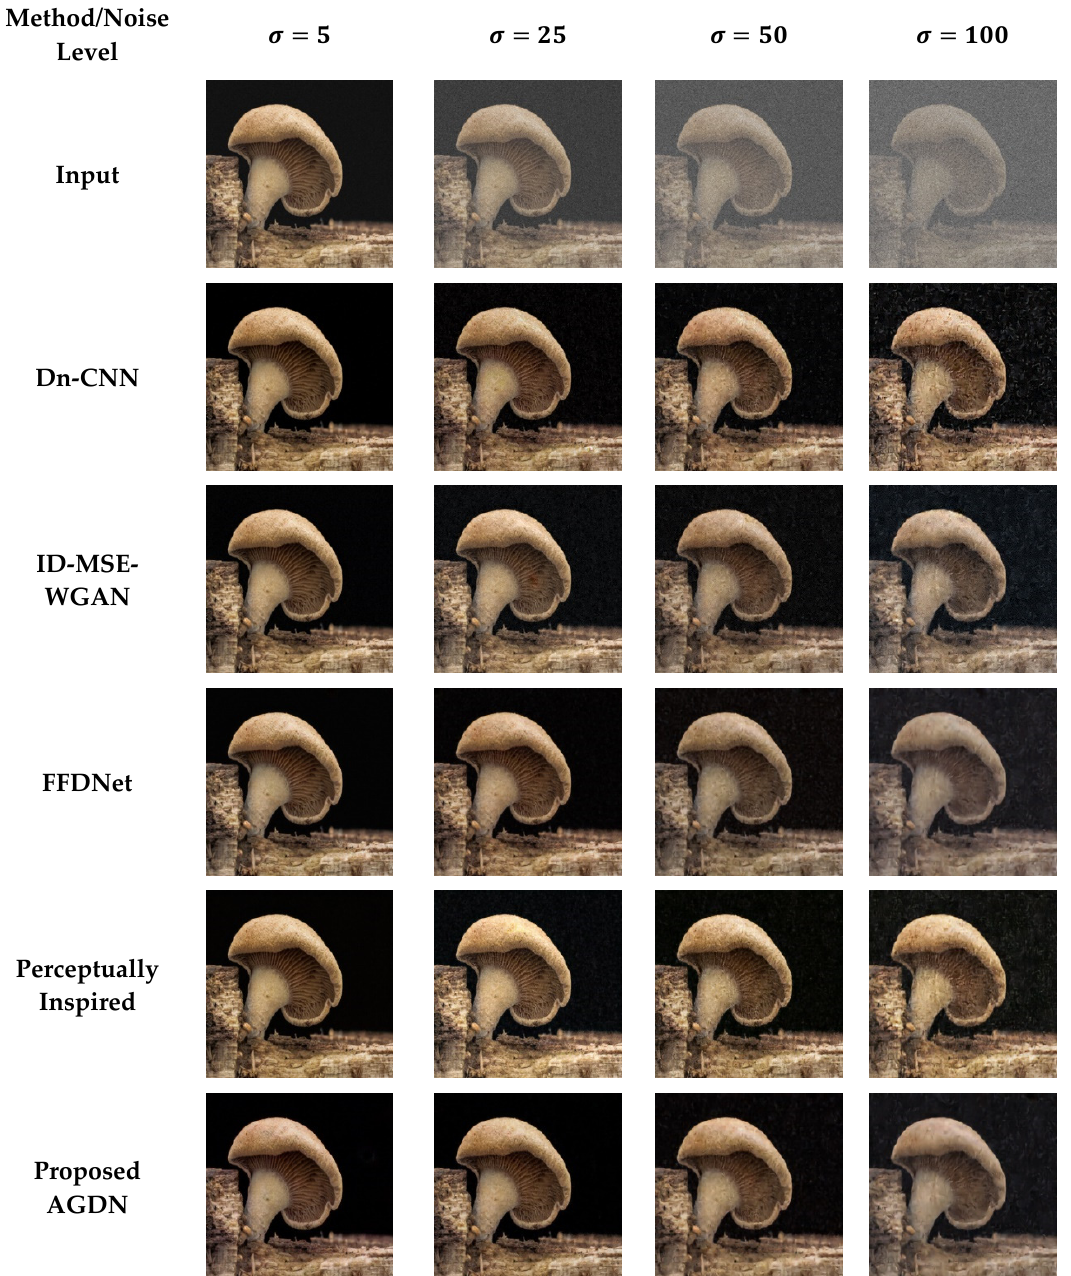
Figure 14. Fourth example results of image denoising tasks on the DIV2K dataset. The first to last column images generated by Table 5. 25, 50, and 100, respectively. First-row shows input images, second-row to the last row presents the results of Dn-CNN, ID-MSE-WGAN, FFDNet, the perceptually inspired method, and the proposed AGDN, respectively.